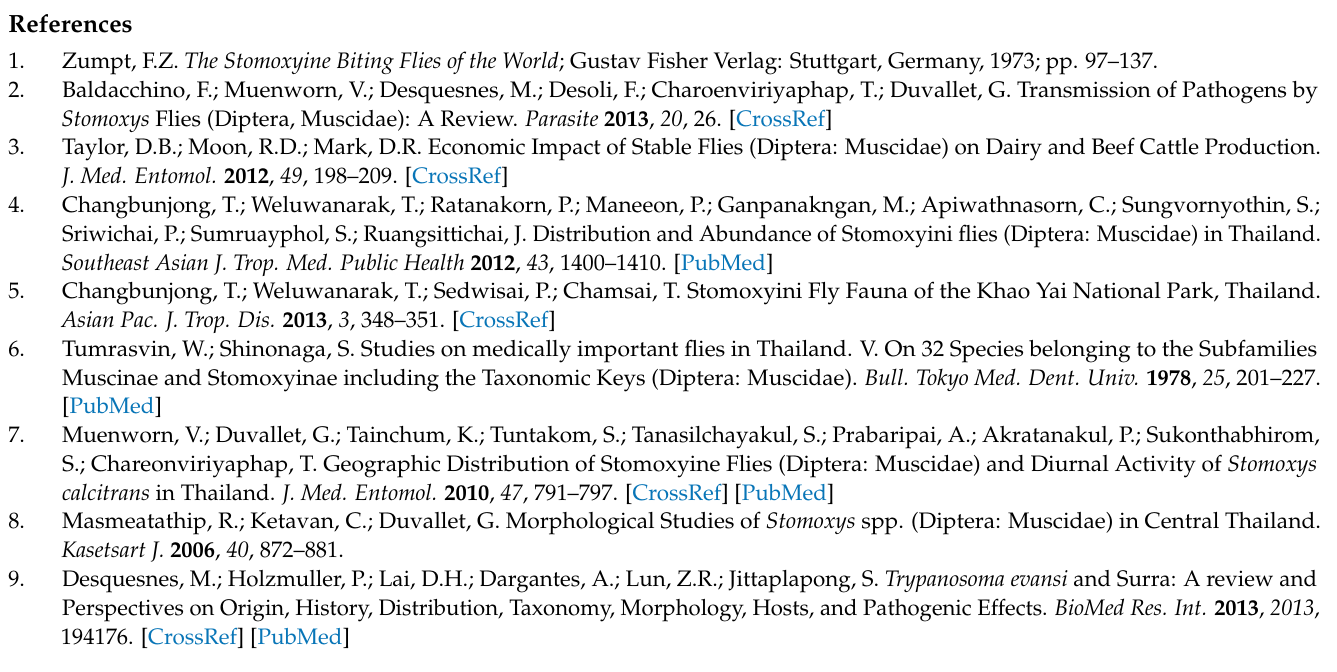
Table S2: Raw coordinates of female wing landmarks of Stomoxys bengalensis (No. 1–65), S. calcitrans (No. 66–140), and S. sitiens (No.